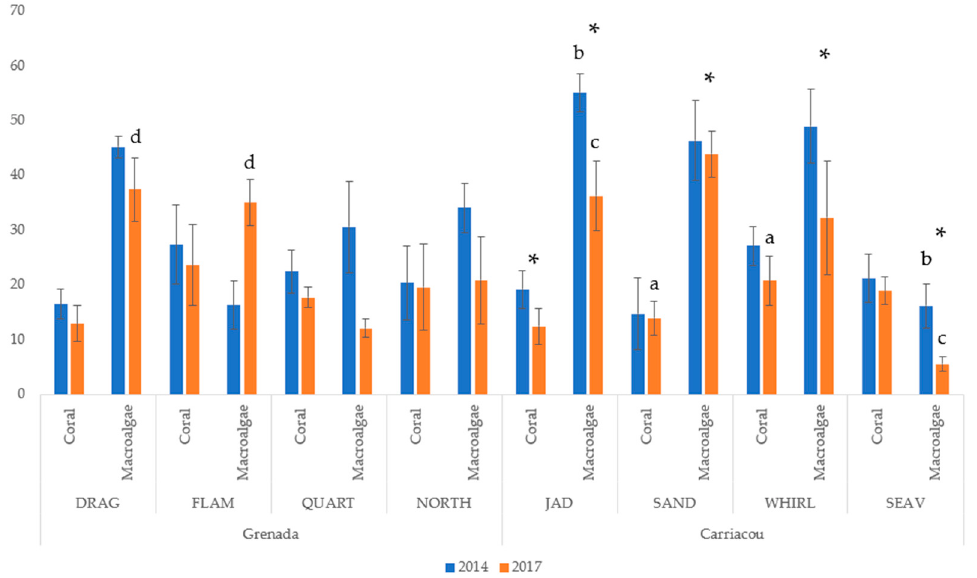
Figure 2. Mean (±SD) of percent coral and macroalgal cover at study sites in Carriacou and Grenada in 2014 and 2017. (*) denotes a significant difference ( p < 0.05) at a single site between years while letters denote a significant difference ( p < 0.05) between sites in a given year.